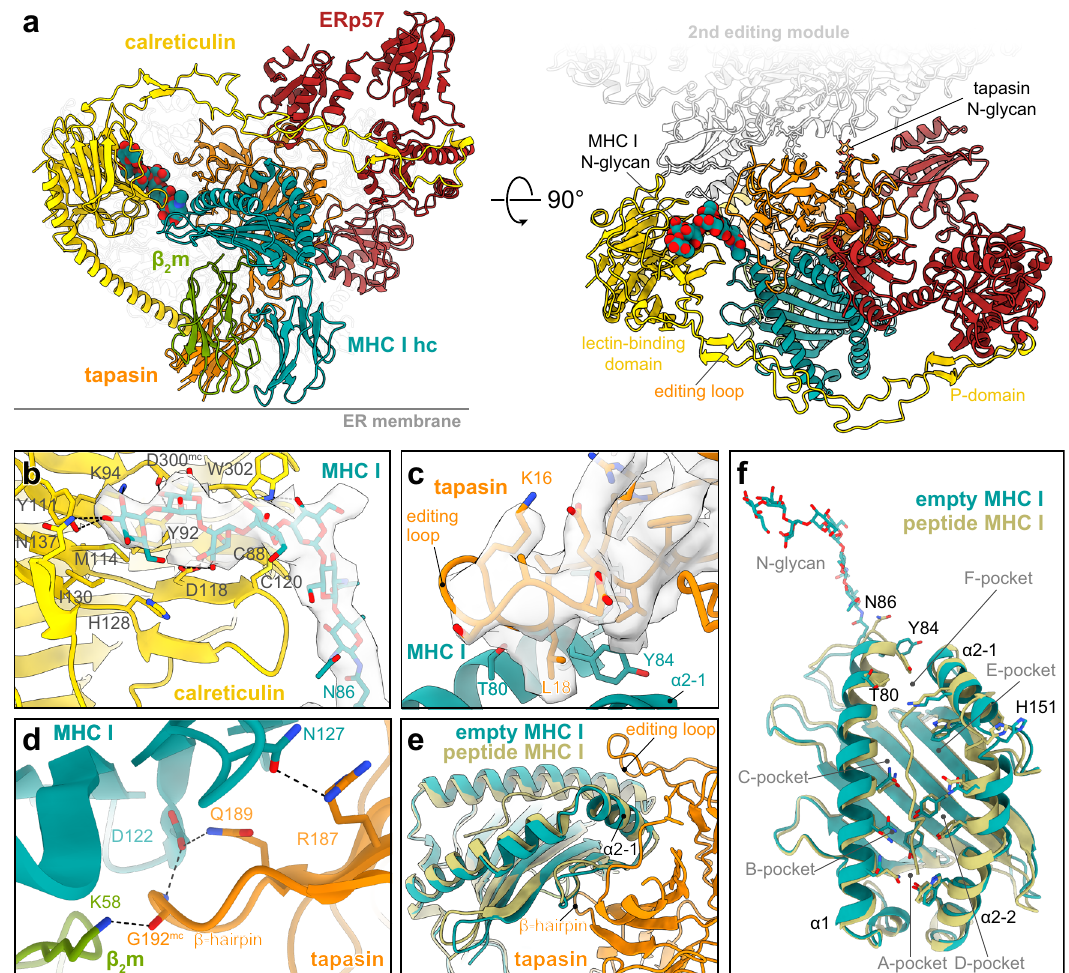
Fig. 2 | Structure of the multivalent MHC I chaperone network in the PLC. a Cryo-EM structure of the peptide-receptive MHC I stabilized by a multivalent chaperonenetworkinthePLCeditingmodule(sideandtopview).Theglycantrees ofMHCIandtapasinareshownasspace- fi llingmodelandstickmodel,respectively. Each subunit is colored separately ( β 2 m, green; calreticulin, yellow; ERp57, red; MHC I hc, teal; tapasin, orange). The position of the second editing module is indicated in light grey. b Interaction of the MHC I glycan with the lectin domain of calreticulin. The cryo-EM map of the glycan isdepicted asa transparent isosurface